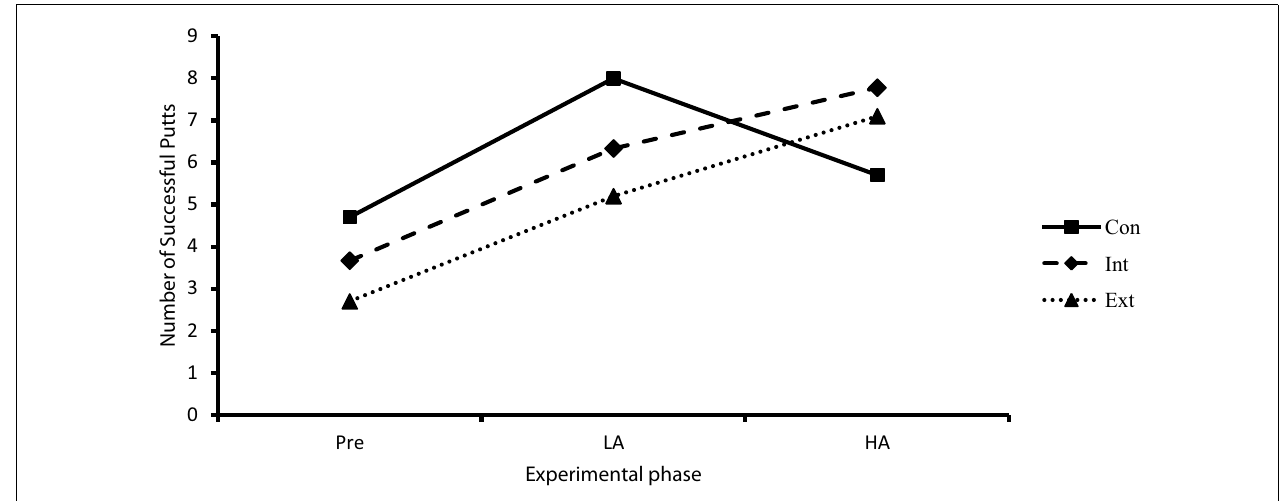
FIGURE 2 | Performance (NSP) as a function of attentional focus (Con, control; Int, internal; Ext, external) and experimental phase (Pre, pre-test; LA, low anxiety; HA, high anxiety).